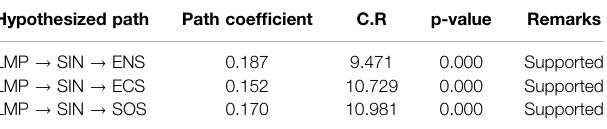
TABLE 9 | Results of path coef fi cients (indirect effects). Hypothesized